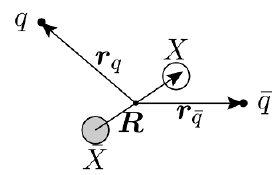
Figure 1. Coordinate system used in the calculation of the rearrangement